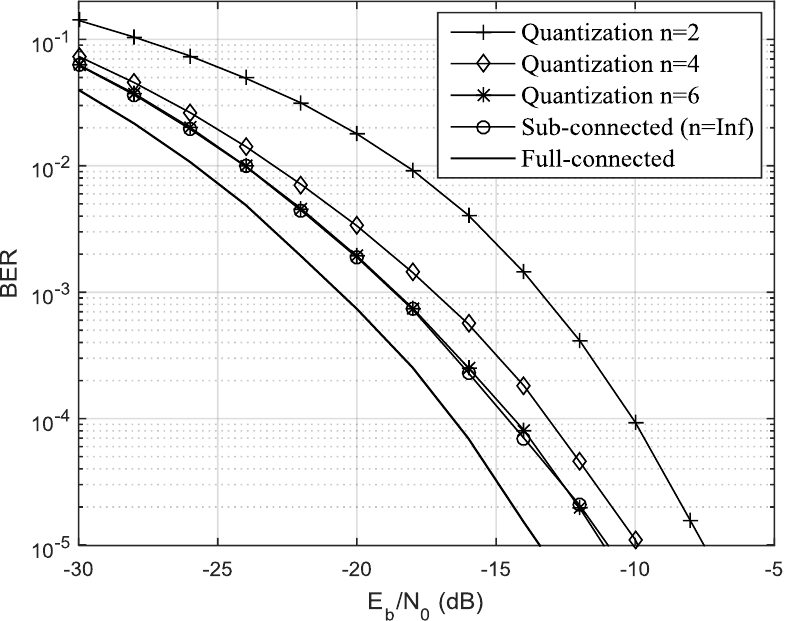
Electronics 2019 , 8 , x FOR PEER REVIEW Figure 4. Performance of the proposed hybrid sub-connected schemes for N RF ∈ { 2,8,16 } and U = 2. Figure 4. Performance of the proposed hybrid sub-connected schemes for { 2 , 8 , 16 } 2 U  .